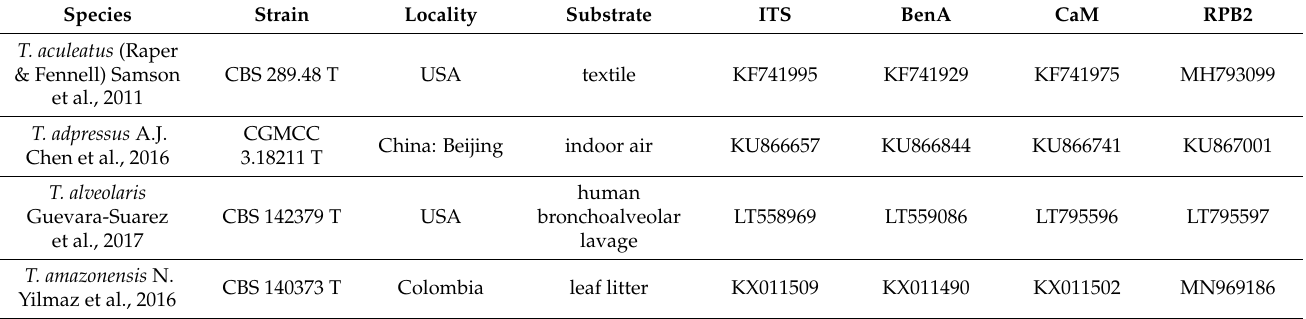
Table 1. Fungal species and sequences used in phylogenetic analyses of Talaromyces sect. Talaromyces . Species